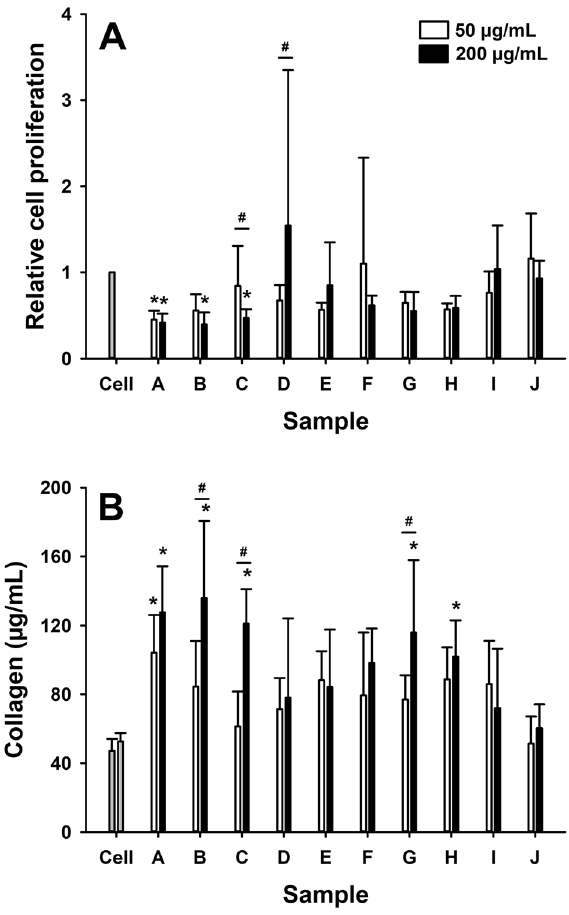
Figure 4. Relative cell proliferation ( A ), measured by WST-assay relative to control (cell only), and soluble collagen production, measured in the cell supernatant by colorimetric assay, in fibroblasts (CRL-1490) in response to 24 h exposure to 50 µg/mL (white bars) or 200 µg/mL (black bars) of coal particles (samples A–J). Data are presented as mean (SD). *p < 0.05, versus cell only; # p < 0.05, 200 µg/mL vs 50 µg/mL.